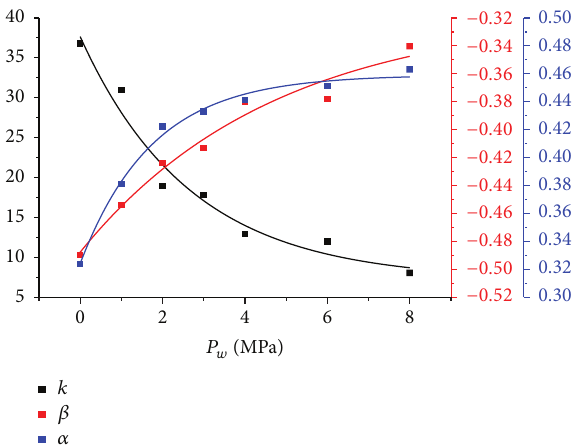
Figure 11: Values and fitted curves of 𝑘 , 𝛼 , and 𝛽 .